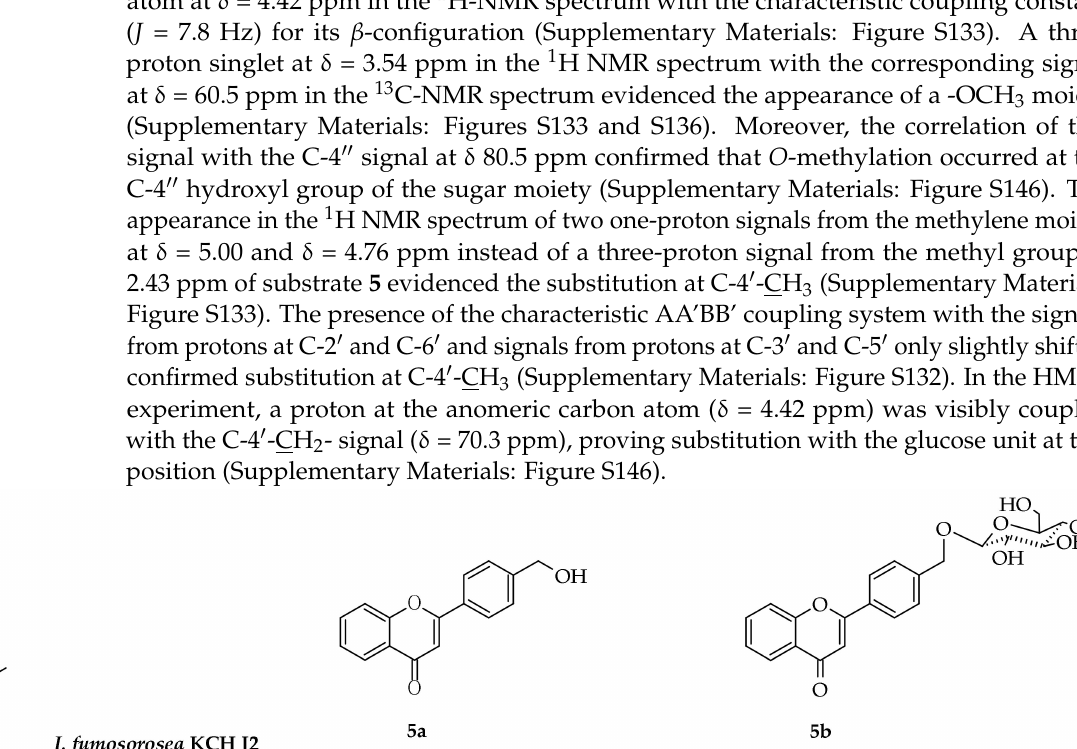
( J = 7.8 Hz) for its β -configuration (Supplementary Materials: Figure S133). A three-